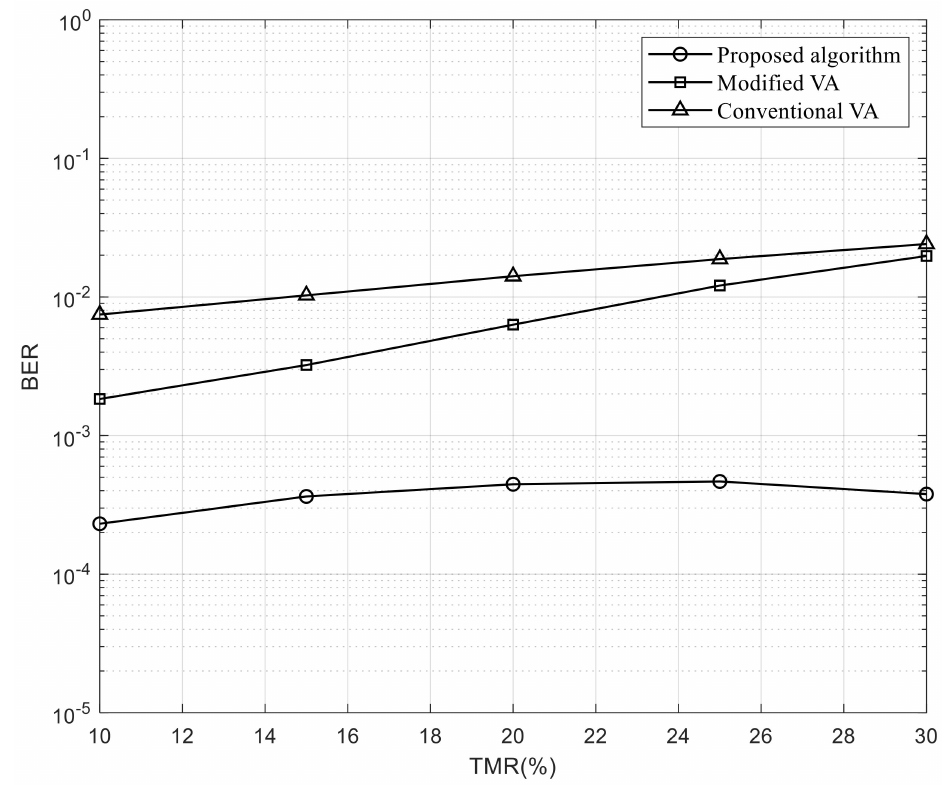
Figure 16. BER versus TMR at 15 dB.